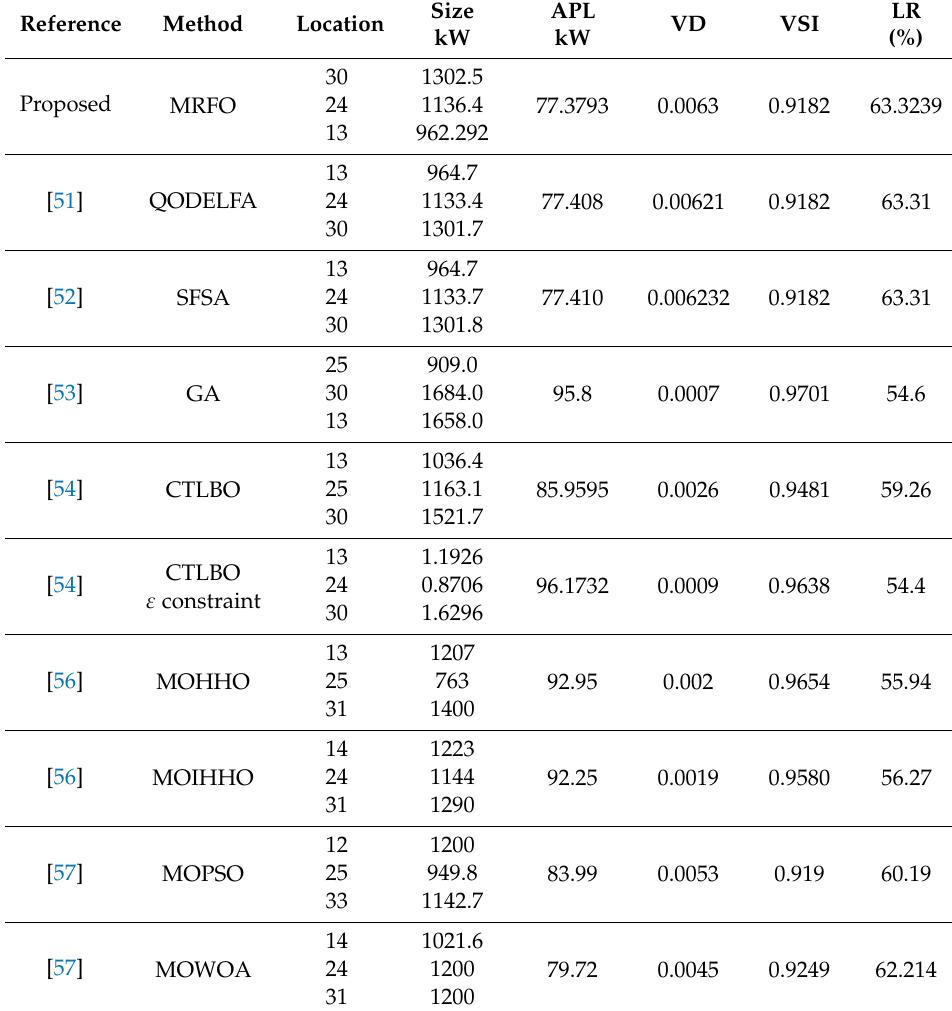
Table 1. 33 bus system, three DG units, at unity Power factor